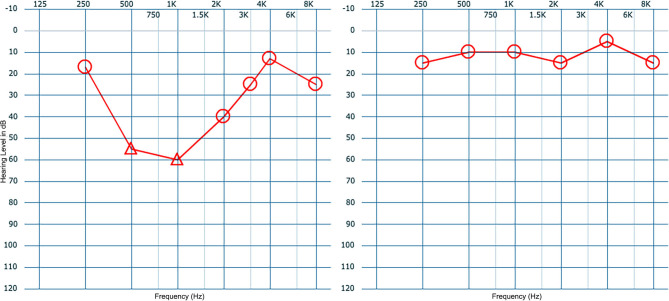
Audiograms of a patient presenting with sudden hearing loss after blowing her nose (left panel) showing improvement of hearing 1 week after a blood patch procedure (right panel).